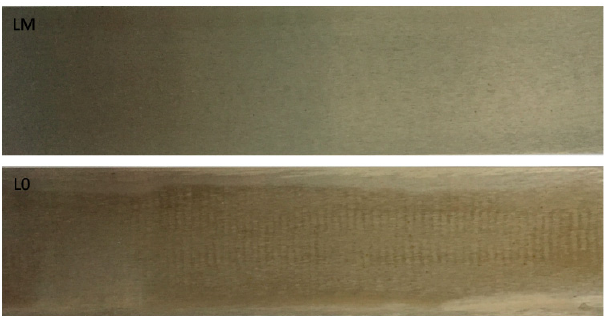
Figure 3. Signs of flash corrosion after an accelerated laboratory test of non-pigmented coating films.